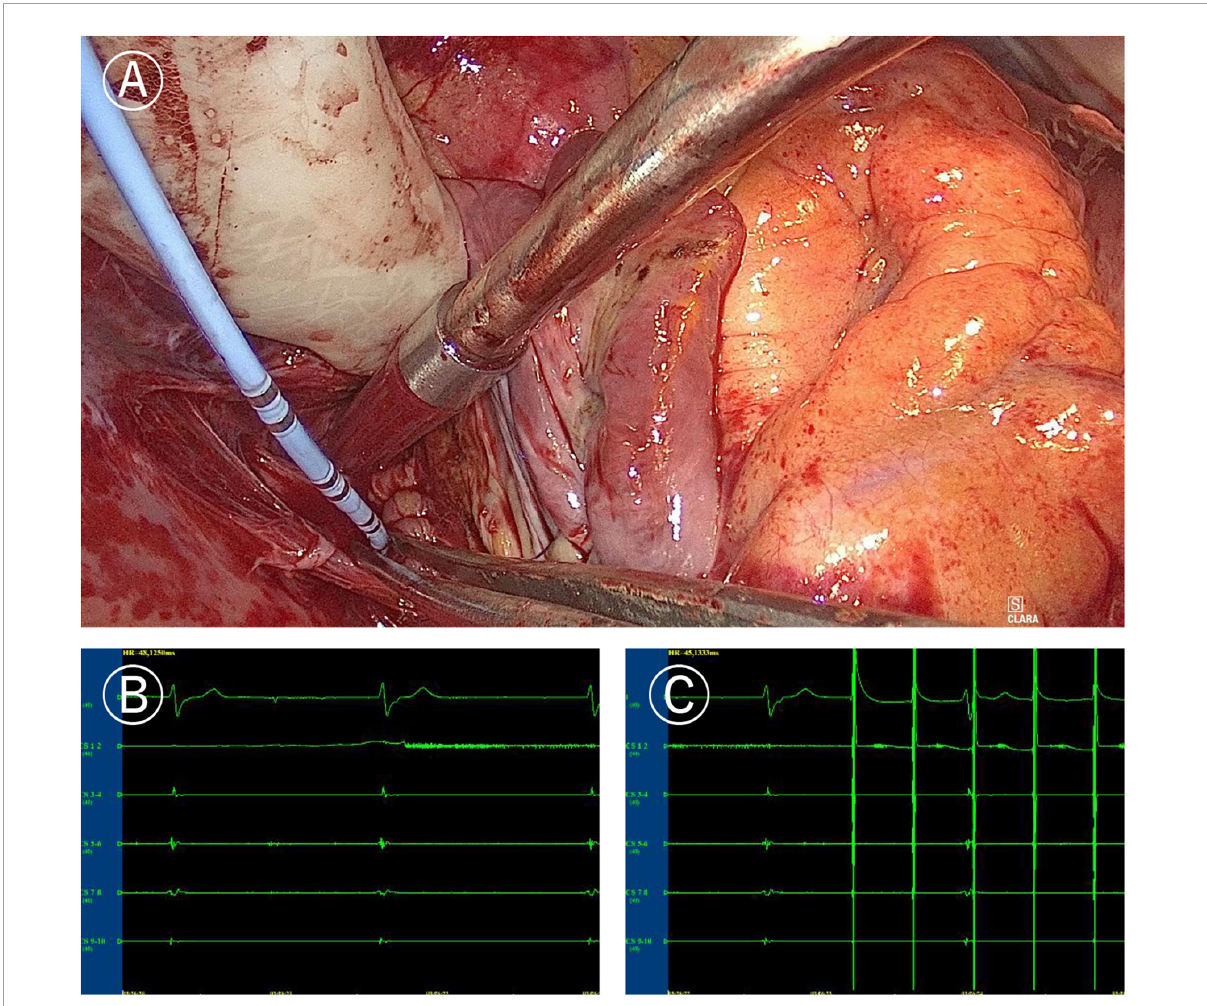
FIGURE3 Mapping of left atrial “box” lesion. (A) Coronary sinus catheter mapping of left atrial “box” lesion. (B) Inner-box polar could not sense the outer potential under sinus rhythm. (C) Pacing of inner-box polar could not capture or disturb the sinus rhythm of the outer